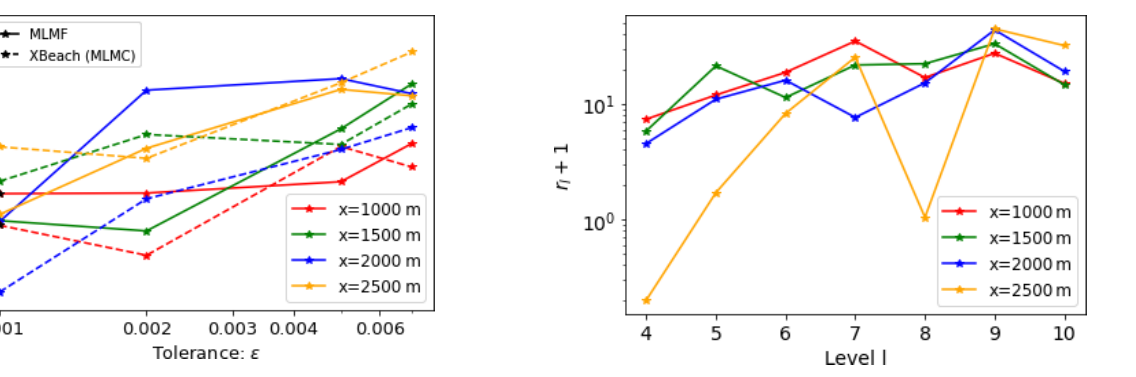
Figure 10. Factor of total LF simulations ( r l + 1) required by MLMF compared to number of HF simulations for the non-breaking wave test case, where r l is Eq. (13).